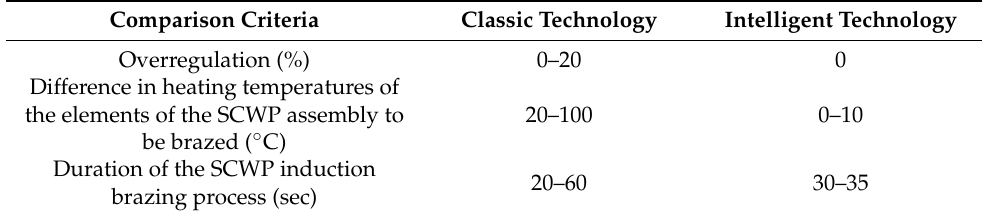
Table 1. Quality comparison of the induction brazing control